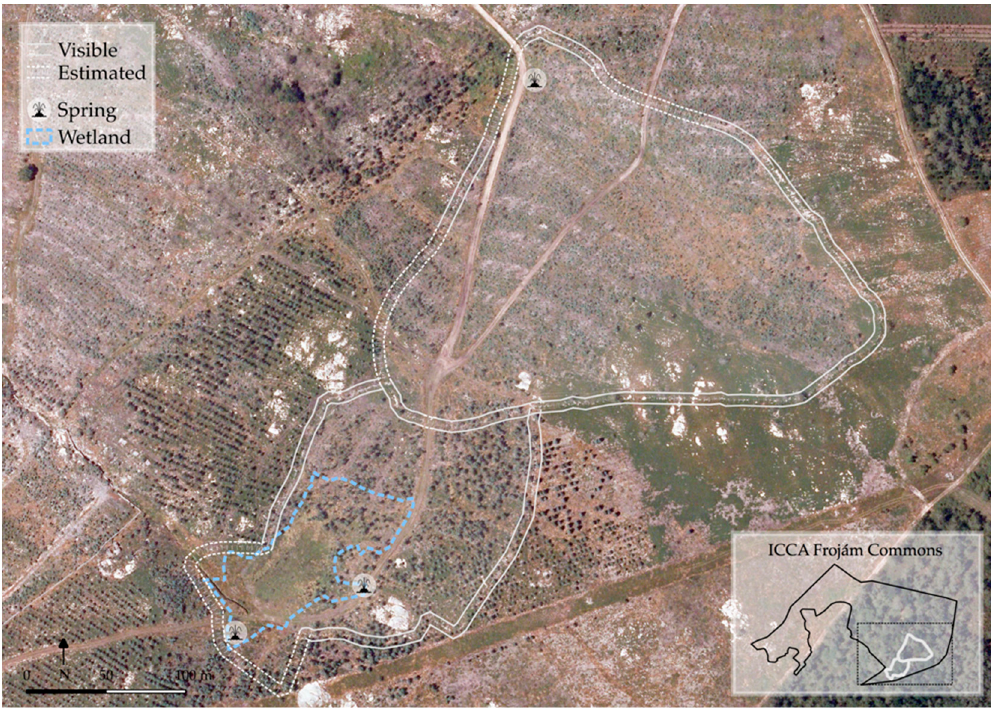
Figure 2. Orthoimage highlighting visible and probable sections of the Frojám enclosure. Based on IGN PNOA ( Plan Nacional de Ortofotografía Aérea ) 2008 images taken after the 2006 forest fires.